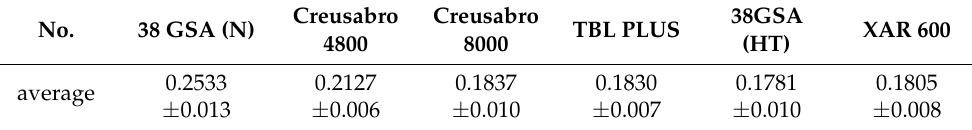
Figure 8. Coefficient of the relative abrasion resistance k bAV of the analyzed types of steels with respect to hardness and prior austenite grain size. Table 2. Mass loss of the tested types of steels (g) with standard deviation